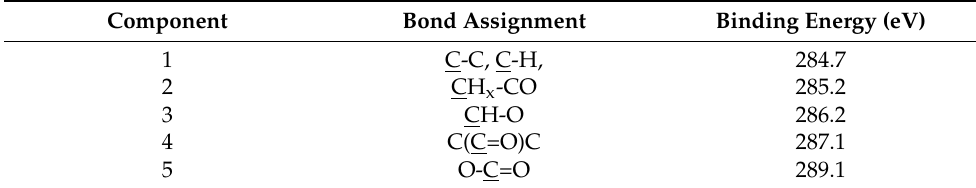
Table 3. Assignment of the C 1s components applied to the fitting procedure of high-resolution XPS C 1s spectra.